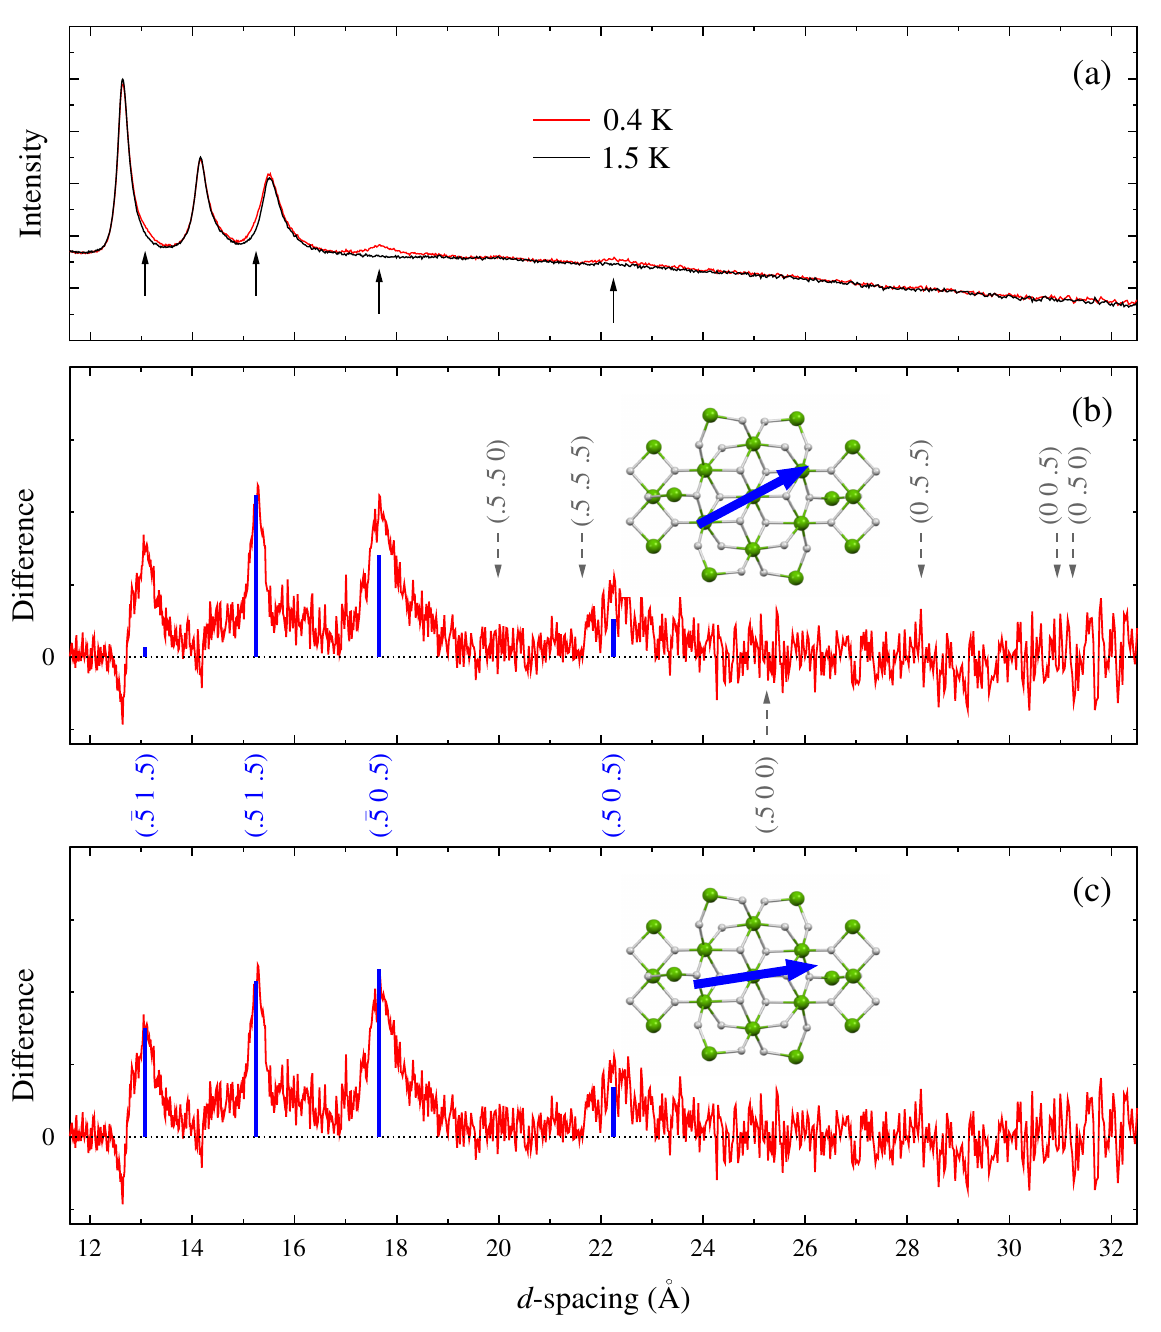
Figure 2. Neutron powder diffraction spectra measured on the WISH instrument. ( a ) Comparison of the data above and below the 1.2 K magnetic ordering temperature. The arrows highlight four new peaks that appear with d spacings in the region between 13 and 23 Å. ( b ) The difference spectrum shows the magnetic peaks more clearly. These new peaks are only consistent with an ordering that has the propagation vector (0.5 0 0.5). The positions of absent peaks that would be present for other modes of ordering are marked in grey. The predicted relative intensities of the observed peaks for (0.5 0 0.5) ordering are marked with blue lines, taking the Fe1–Fe2 orientation of the easy axis that was suggested by EPR [13] (shown as the blue arrow). ( c ) An improved match to the measured intensities is obtained with a revised spin orientation that is close to the Fe1–Fe10 axis of the molecule (see Table